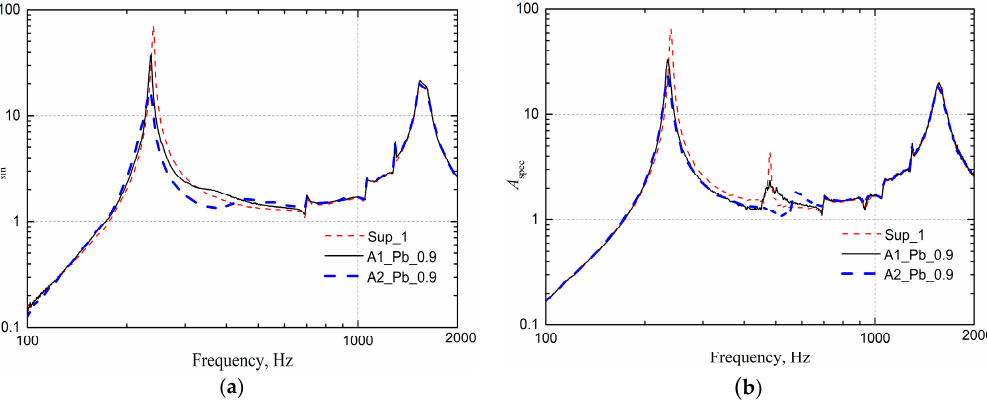
Figure 13. Experiment results of 2 mm lead particles for A1 and A2 cavity (layering in Y-direction of the cavity): ( a ) Sinusoidal excitation; ( b ) Random excitation.